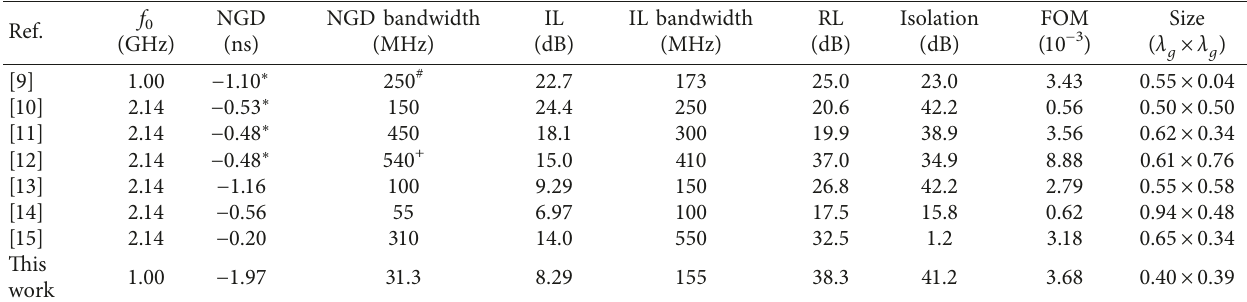
Table 2: Performance